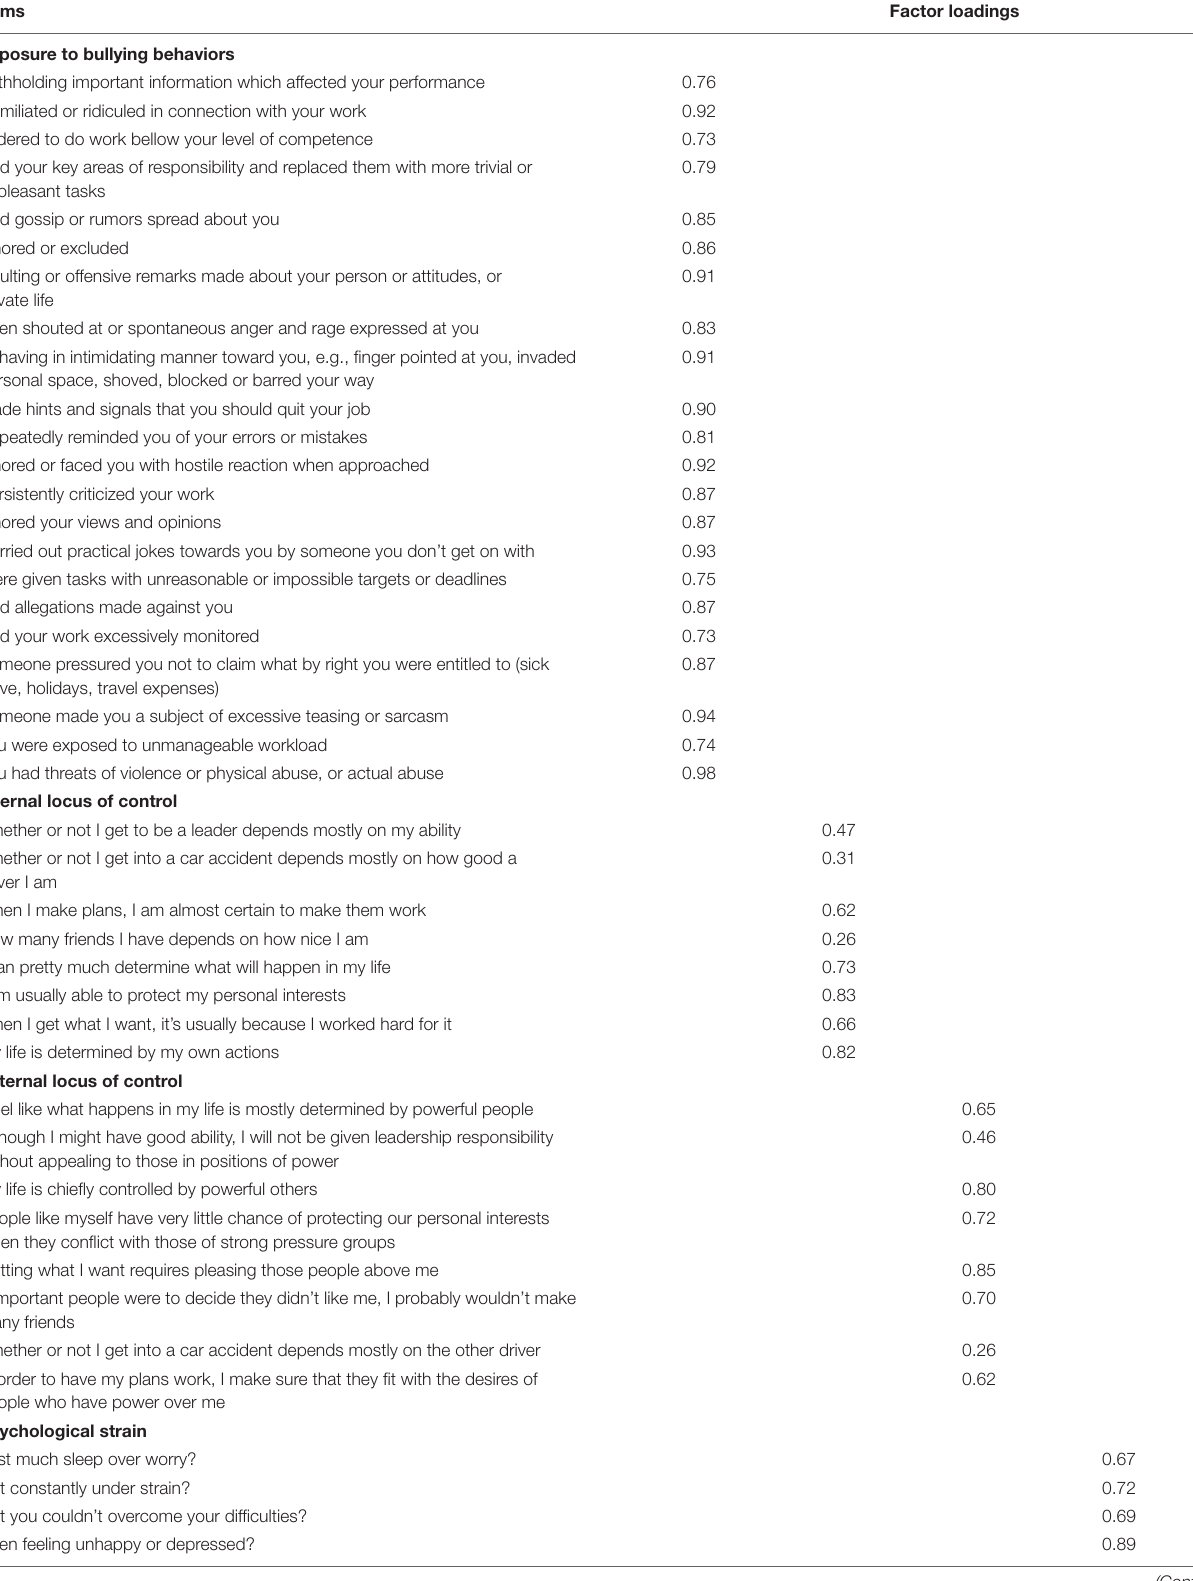
TABLE 3 | Items and standardized factor loadings for the included